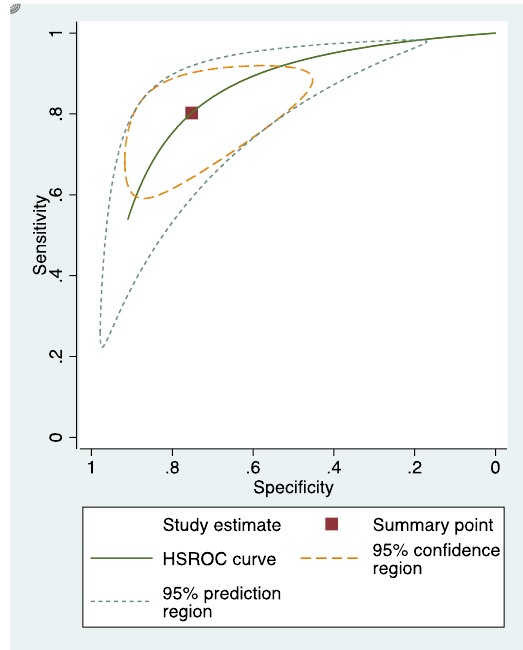
Figure 5. sRoc curves of visual inspection on occlusal surfaces.